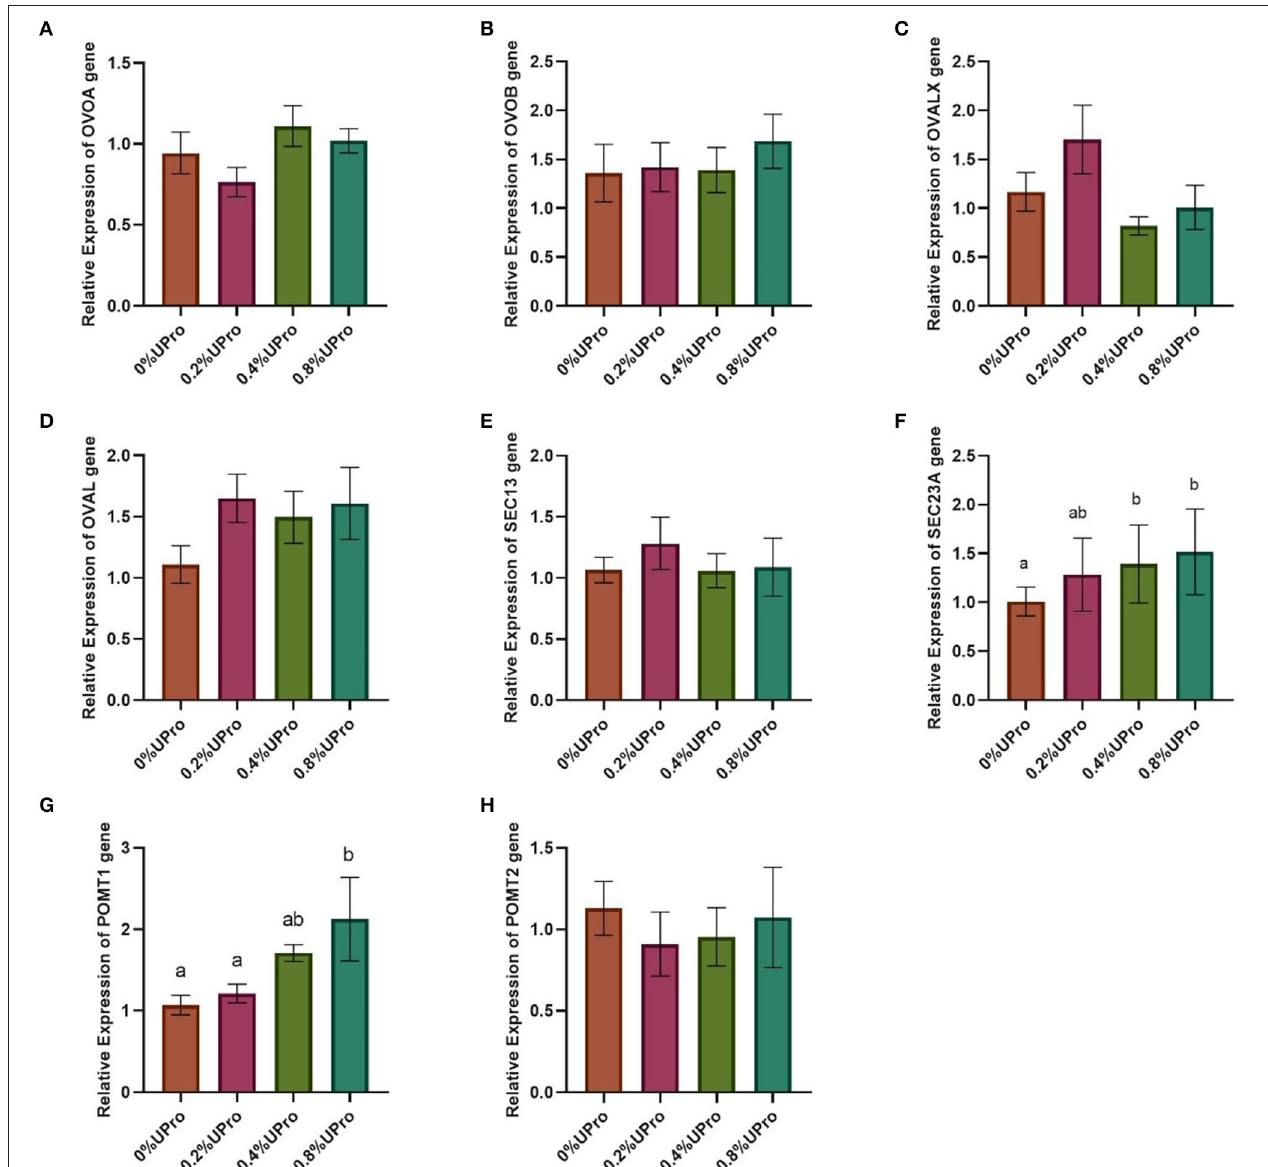
FIGURE 2 | Effects of UPro levels on the relative expression of different genes in the magnum of laying hens. Samples were determined by qPCR. β -actin was regarded as the reference genes. (A,B,C and D) genes related to protein synthesis ( OVOA , ovomucin, alpha subunit; OVOB , ovomucin, beta subunit; OVALX , ovalbumin-related protein X; OVAL , ovalbumin); (E,F) genes related to protein secretion ( Sec13 , Sec13 homolog, nuclear pore and COPII coat complex component; Sec23A , Sec23 homolog A, COPII coat complex component); (G,H) Genes related to protein glycosylation ( POMT1 , protein-O-mannosyltransferase 1; POMT2 , protein-O-mannosyltransferase 2). The bars with no common letters significantly differ ( P < 0.05).